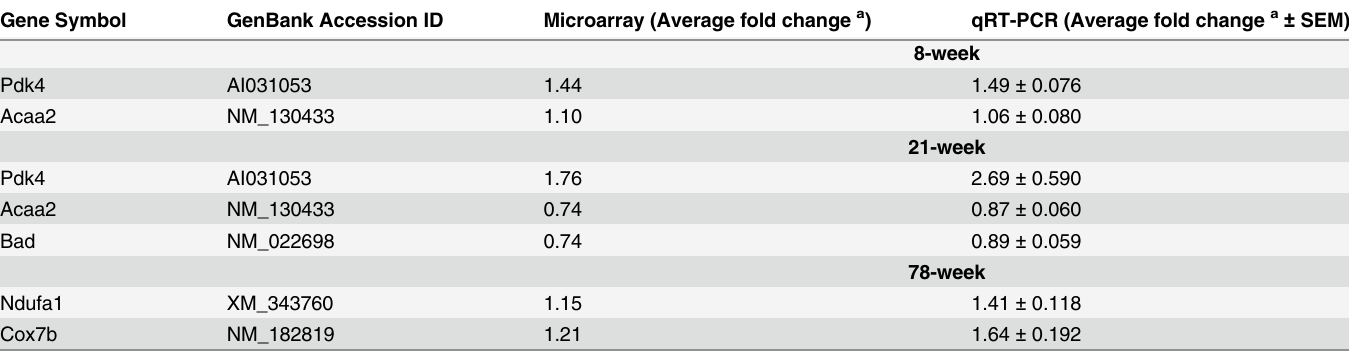
Table 2. Veri fi cation of signi fi cantly altered genes by quantitative real time PCR (qRT-PCR). Gene